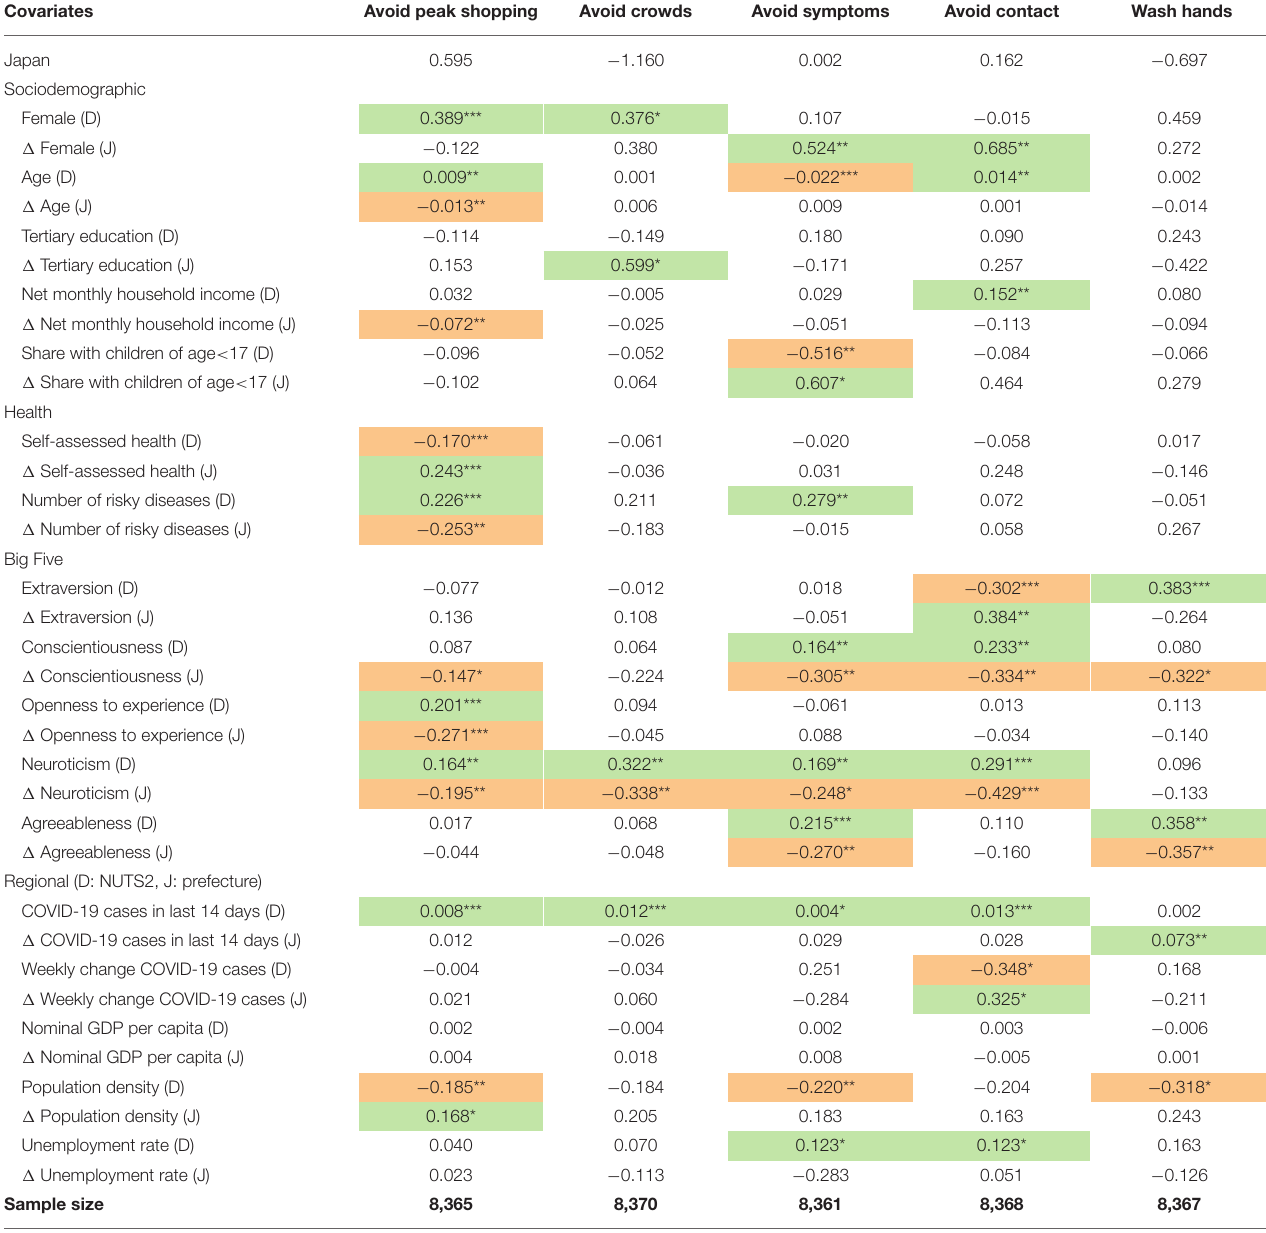
Table 3.2 | Regression coefficients of covariates on attitudes and behavior (2). Covariates Avoid peak shopping Avoid crowds Avoid symptoms Avoid contact Wash